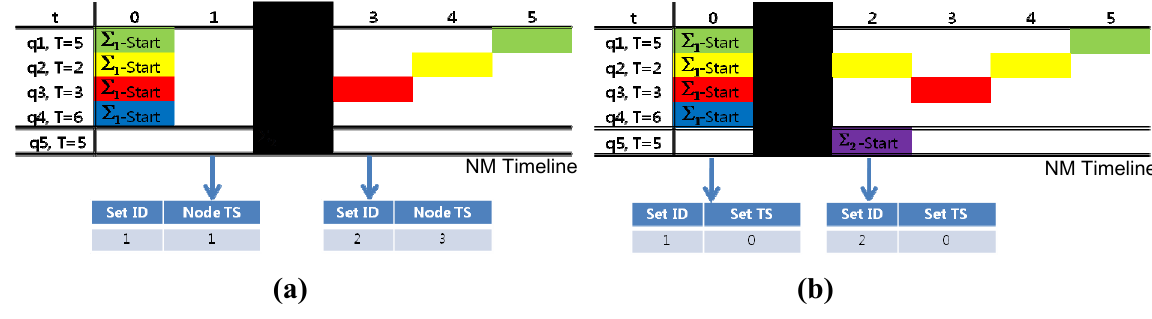
Figure 9. Examples of how single time stamps can be misleading in case of communication failures. (a) The response message only contains node time stamp. (b) The response message only contains set time